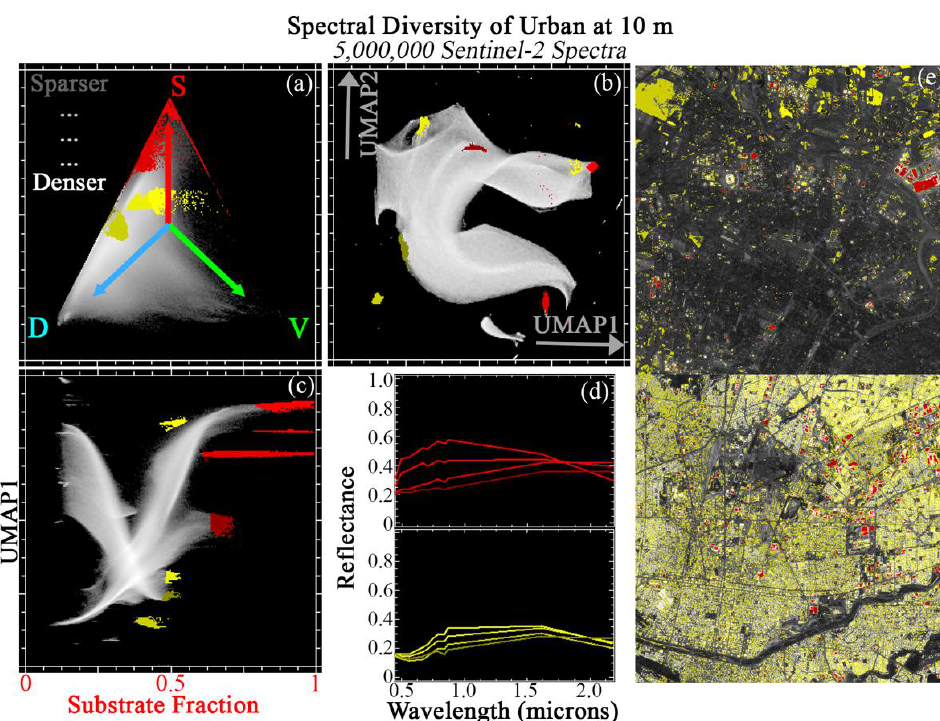
Figure 7. Joint characterization of urban landscapes. 5 × 1 megapixel Sentinel-2 tile subsets are selected from global urban hotspots and analyzed at full 10 m pixel resolution. These spectra fill out most of the SVD mixing space ( a ). The global 3-endmember linear mixture model fits these spectra less well than the agricultural spectra (here, 97.5% of spectra with <5% RMSE). UMAP ( b ) captures both subtle mixing continua and discrete clusters, but does not offer physical interpretability. Joint characterization ( c ) uses the physical meaning of the Substrate mixture fraction to contextualize the subtle statistical relationships captured by UMAP. Example regions of interest are identified from the joint space and projected onto the ternary mixing and UMAP spaces. Mean spectra for each